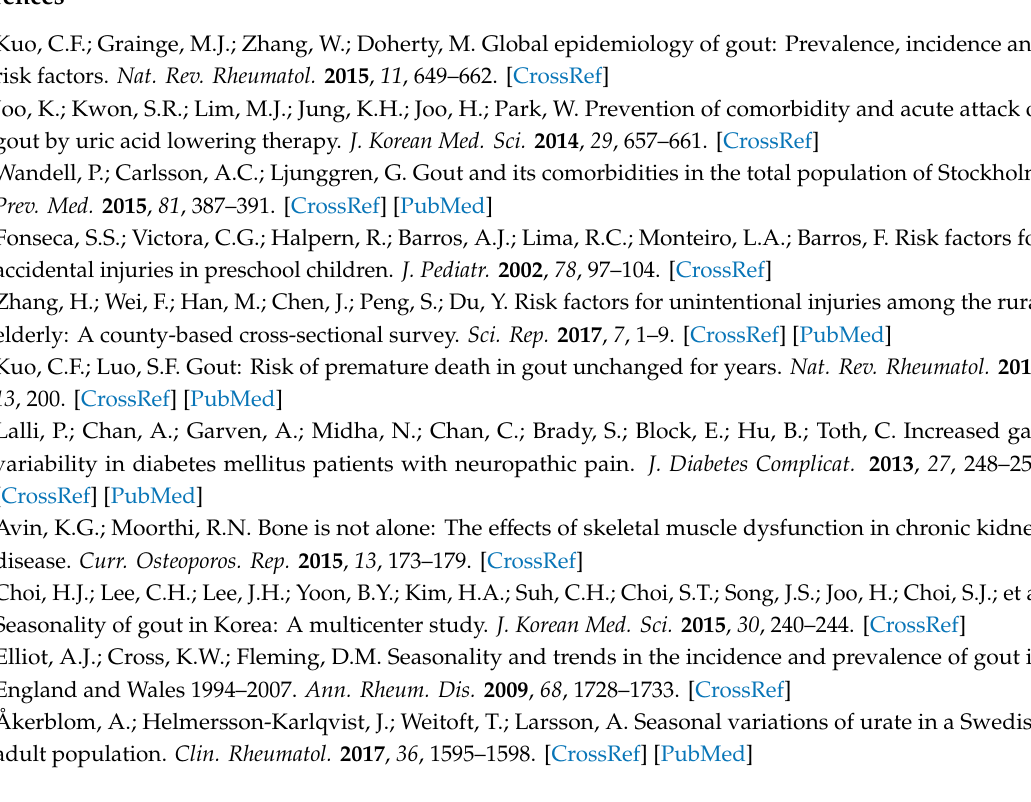
Figure S1: Flowchart of enrollment of patients with gout (group CGF), matched with those without gout (group C), Figure S2: Flowchart of enrollment of injured patients on medication and those without